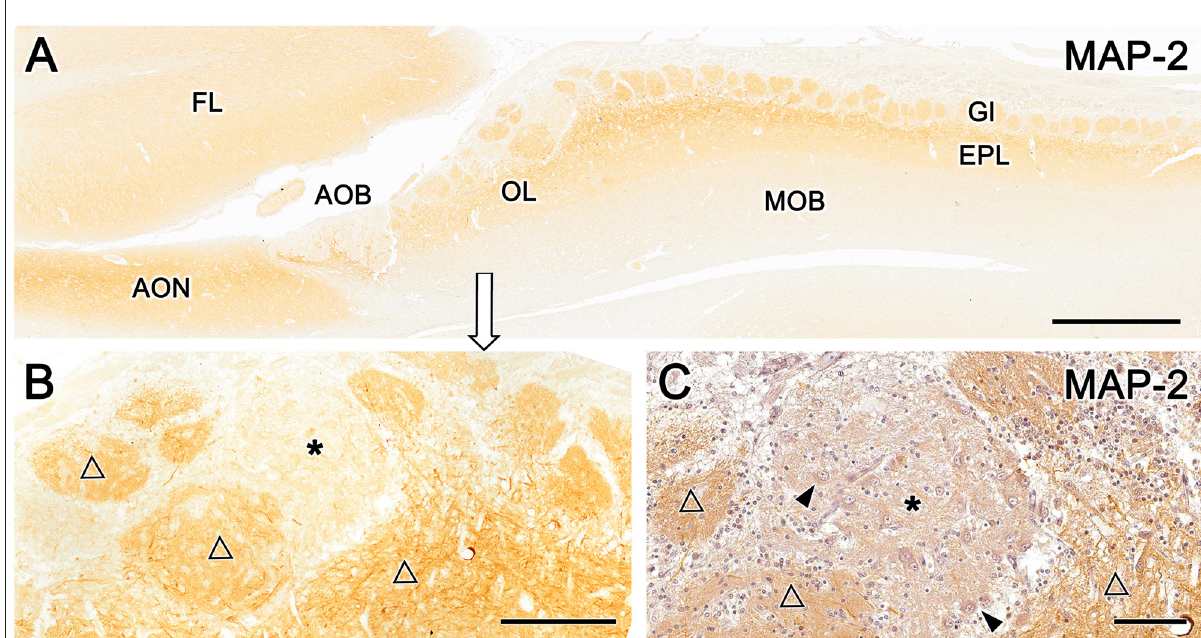
FIGURE9 Immunohistochemical labeling of the fox olfactory limbus (OL) with anti-microtubule-associated protein 2 (MAP-2). (A) Immunostaining with anti-MAP-2 results in the strong and uniform immunolabeling of glomeruli (Gl) and the external plexiform layer (EPL) of the main olfactory bulb (MOB). (B) A higher magnification view of the rostral part of the OL shows the staining of atypical Gl formations (open triangles), in addition to a patch of the nervous formation that remains unstained (*). (C) Anti-MAP-2 immunostained serial sections were counterstained with hematoxylin, confirming that the unlabeled area corresponds to an area of the macroglomerular complex that is rich in neuronal bodies (arrowheads) and receives the innervation from Ulex europaeus agglutinin-positive fibers. AOB, accessory olfactory bulb; AON, anterior olfactory nucleus; EPL, external plexiform layer; FL, front lobe of the telencephalon; Gl, glomeruli; MOB, main olfactory bulb; OL, olfactory limbus. Scale bars: (A) : 1 mm. (B) : 250 µ m. (C) : 100 µ